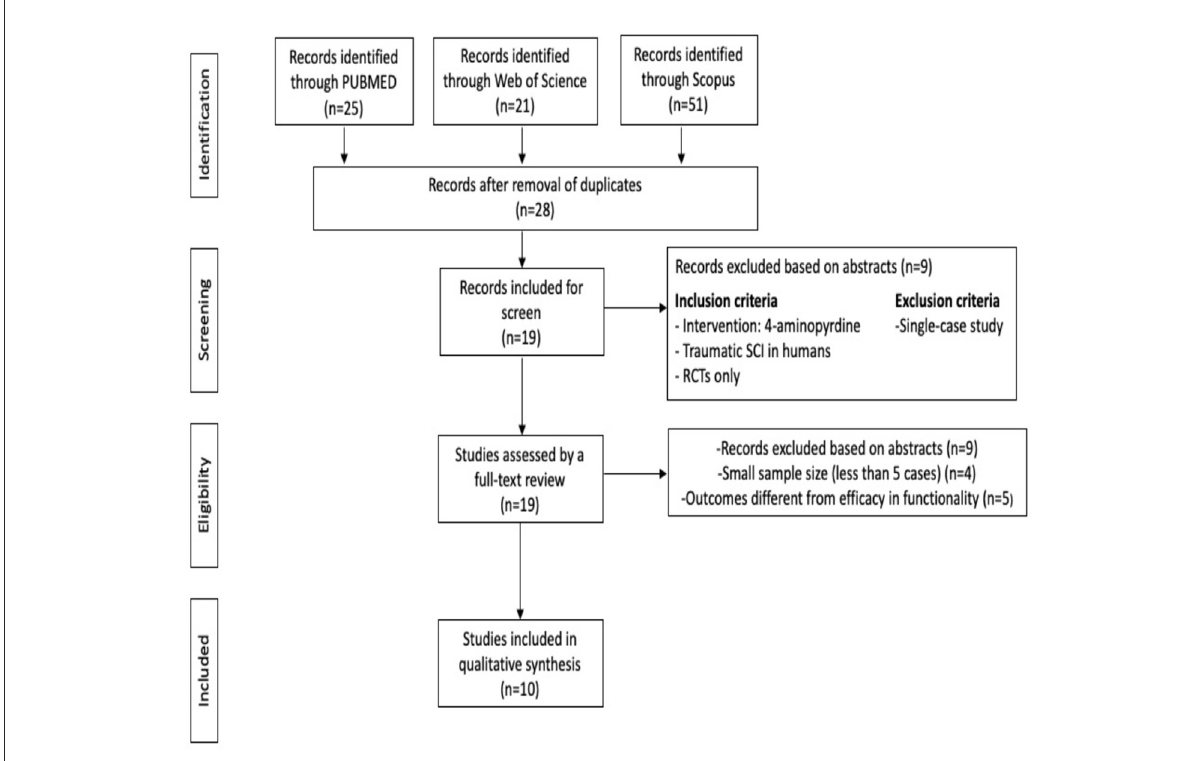
FIGURE1 PRISMA flow diagram describing the screening and review process